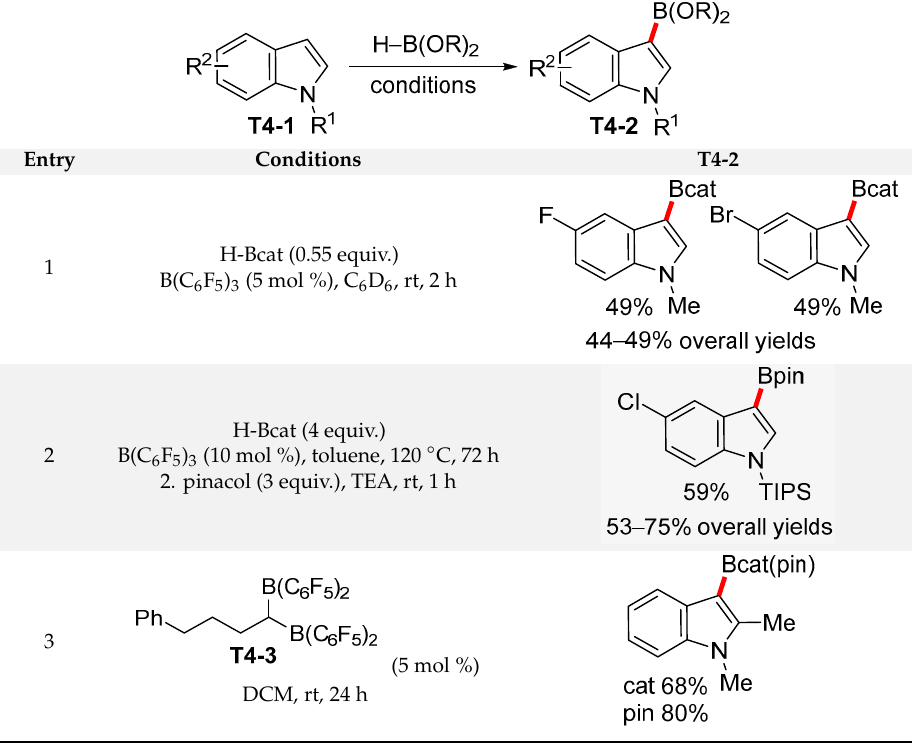
Table 4. Lewis-acid-catalyzed borylation of indoles and electron-rich arenes.